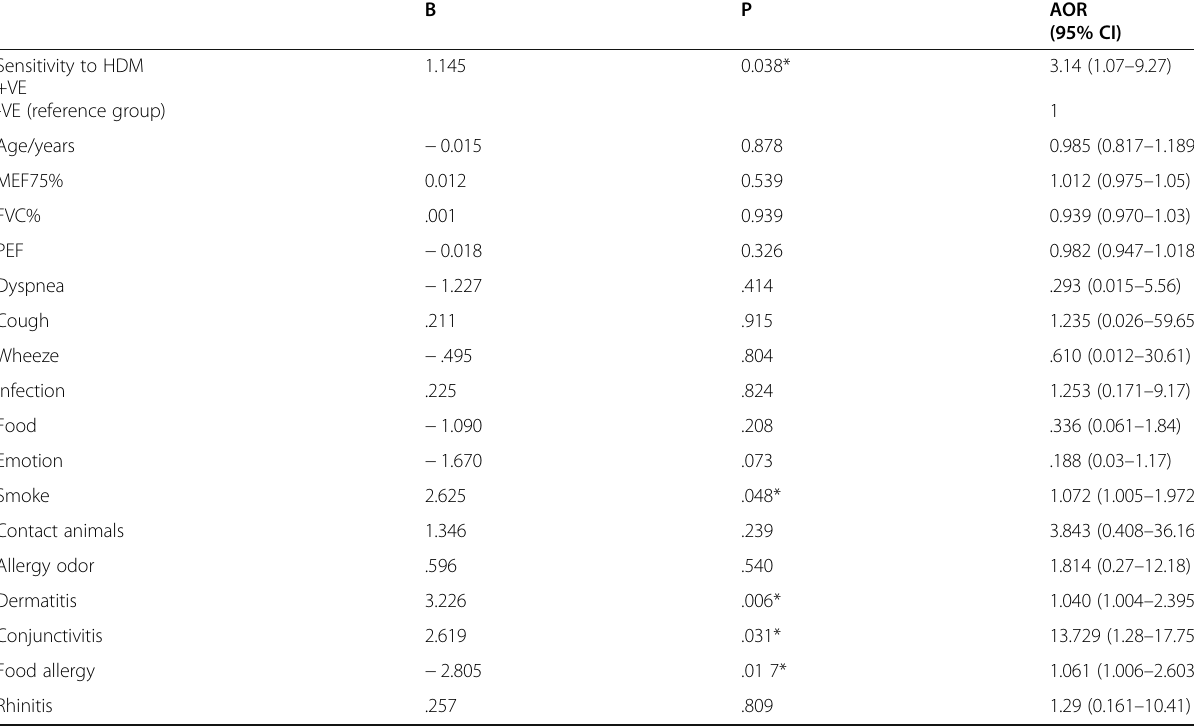
Table 3 Predictors of moderate and severe asthma among studied